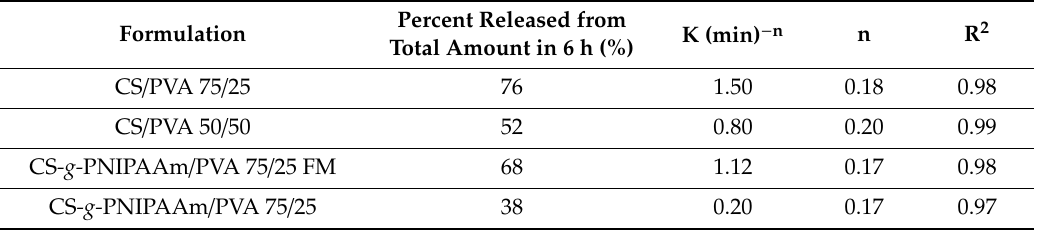
Table 3. Kinetic parameters calculated for the release profiles of Voriconazole from CS -g- PNIPAAm / PVA and CS / PVA cryogels.